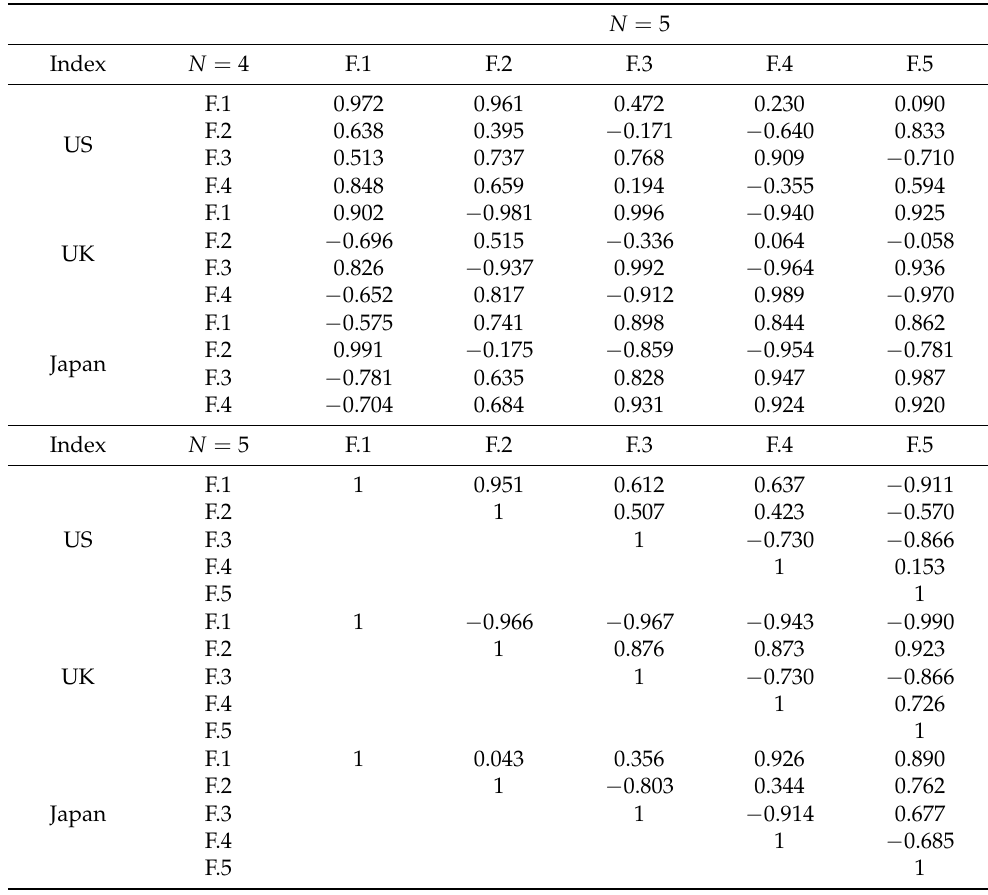
Table 4. Correlation coefficients between the AE results for five features and the AE results for four and five features. Here, Here, N is the number of layers and F.i denotes feature